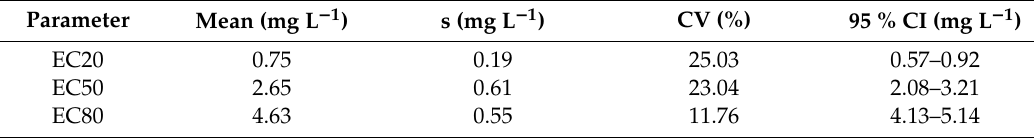
Table 4. Toxicity of Cr (VI) at an incubation time of 30 min, as determined by the modified method. These data served for comparative purposes with the standard procedure. The number of repetitions was seven. s = standard deviation, CV = variation coe ffi cient and CI = confidence